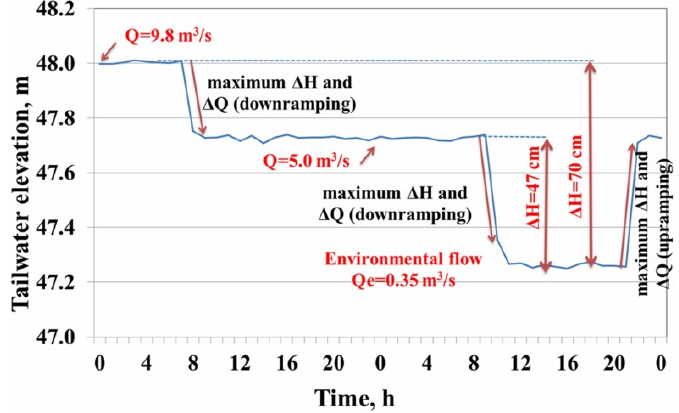
Figure 9. Hourly tailwater level ( H ) fluctuations at Angiriai SHP. At the beginning, 2 turbines ( Q T = 9.8 m 3 /s) are working, then 1 turbine was shut down ( Q T = 5 m 3 /s) and finally both are shut down. Later, 1 turbine was started up again (3–4 March 2009).